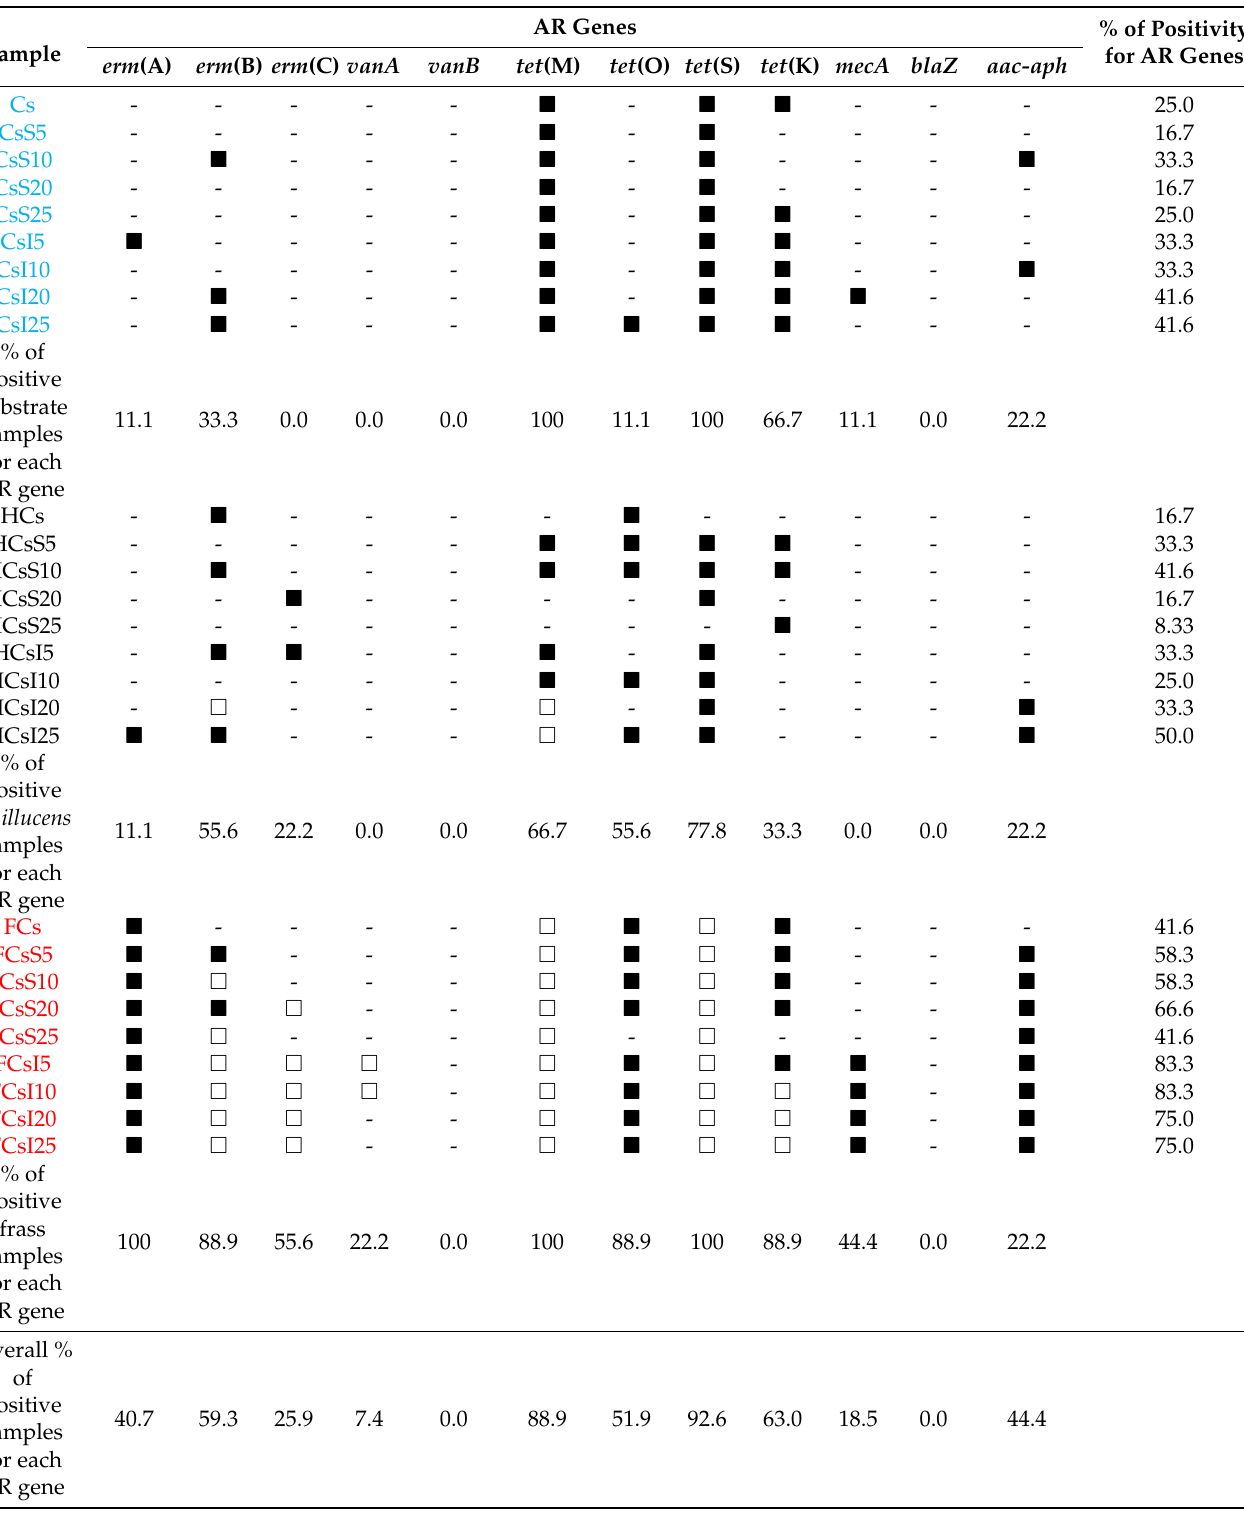
Table 1. Antibiotic resistance (AR) genes detected by PCR and nested